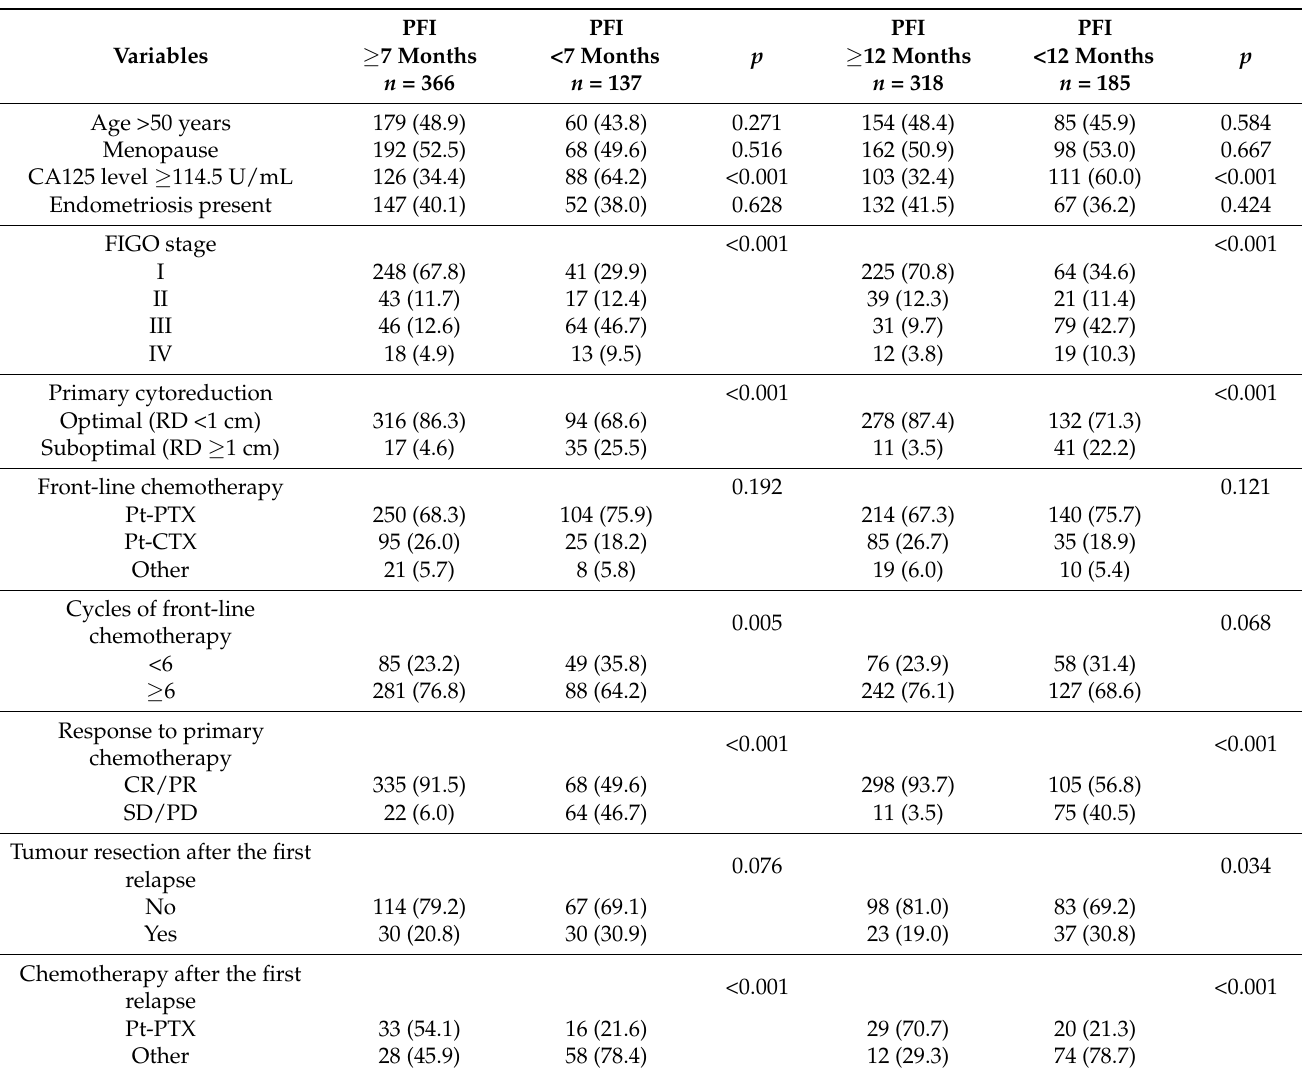
Table 3. Correlations between patient characteristics and PFI of 7 or 12 months among the multi- institutional OCCC patients treated with front-line